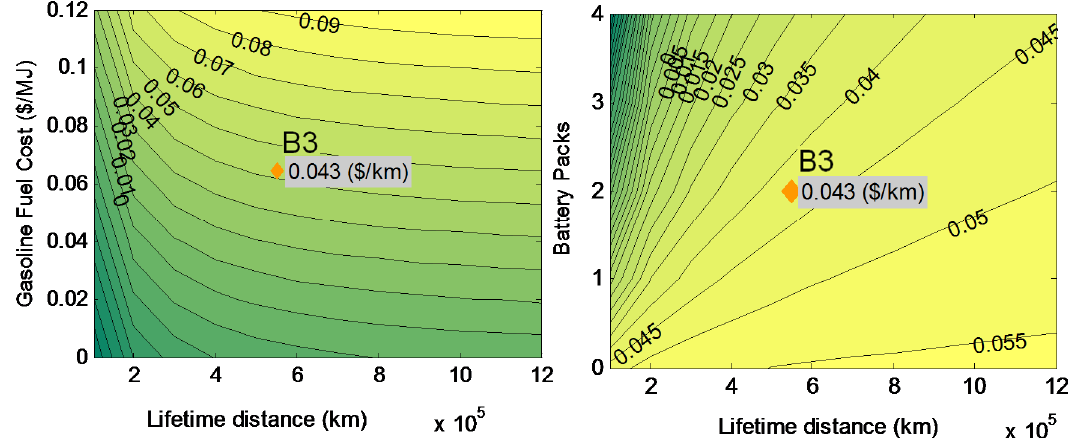
Figure 12. Financial gain considering the gasoline cost and the number of battery packs for the BL driving cycle, of optimal solution B3.